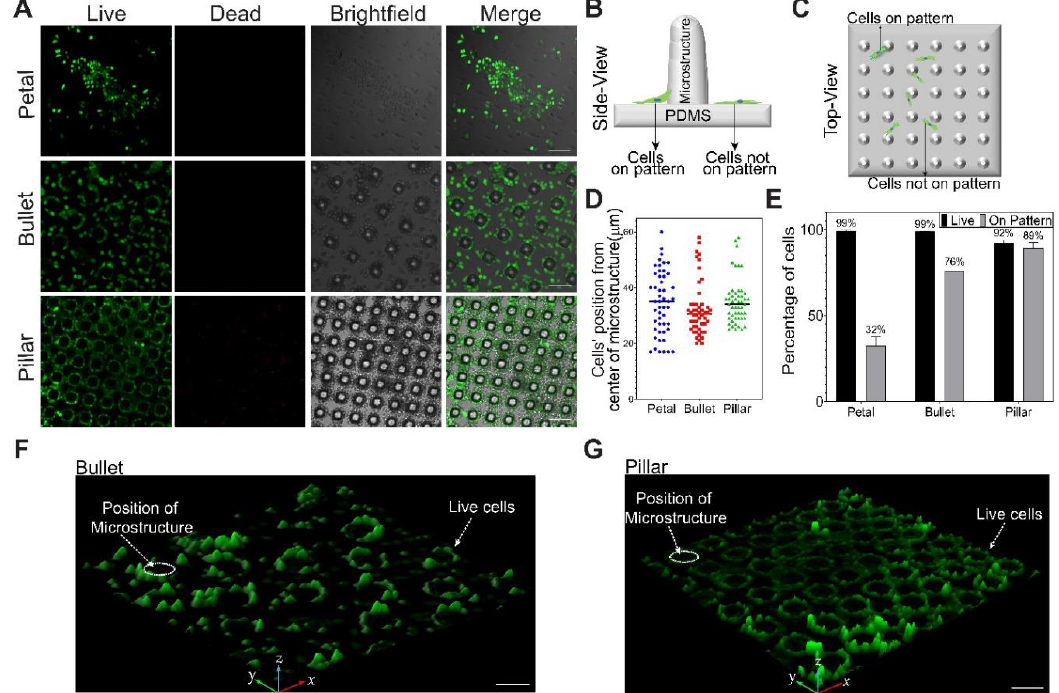
Figure 6. Fibroblast cell patterning on the MSAs. ( A ) Microscopic images revealed a weak, moderate, and strong patterning of fibroblast cells on Fn-coated Petal, Bullet, and Pillar, respectively. Cells showed high viability (virtually no dead cells) on all the array structures. ( B ) Side- and ( C ) top-view schematics illustrated the definition of cells on the pattern and not on the pattern (off-pattern). ( D ) Scatter plot of the cell distance from the center of the microstructure. Scale-0 of the Y-axis represents the center of the microstructure. Bullet and Pillar showed cells mostly arranged close to the microstructure, but Petal showed a random distribution of cells around the microstructures. ( E ) Cell patternability and viability in percentage. ( F , G ) 3D projection of live cells on the Bullet and Pillar substrates revealed that the cells attached to the pattern showed upward elongation along the walls of the microstructure. Error bars: ( E ) STDEV. Scale bar: ( A ) 100 μm; ( F , G ) 50 μm.